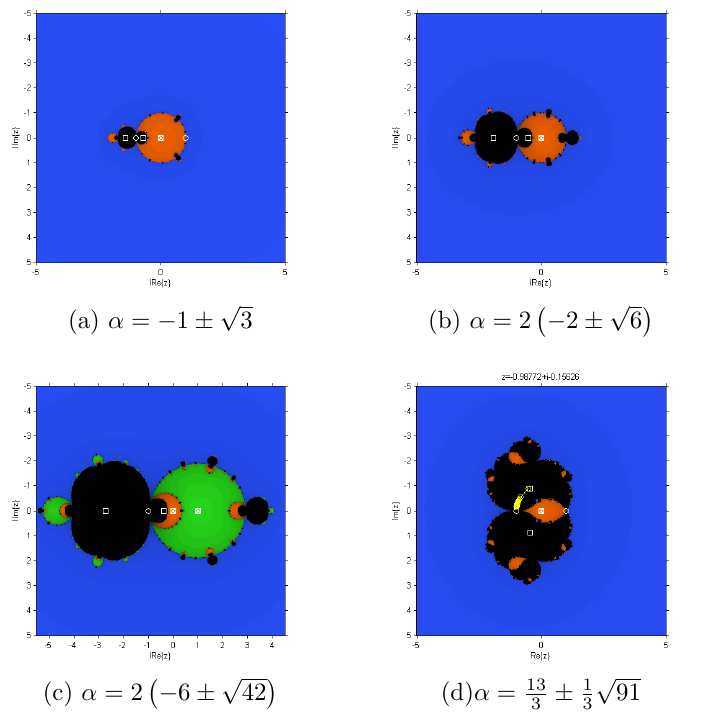
Figure 6. Dynamical planes of the operator G ( z,α